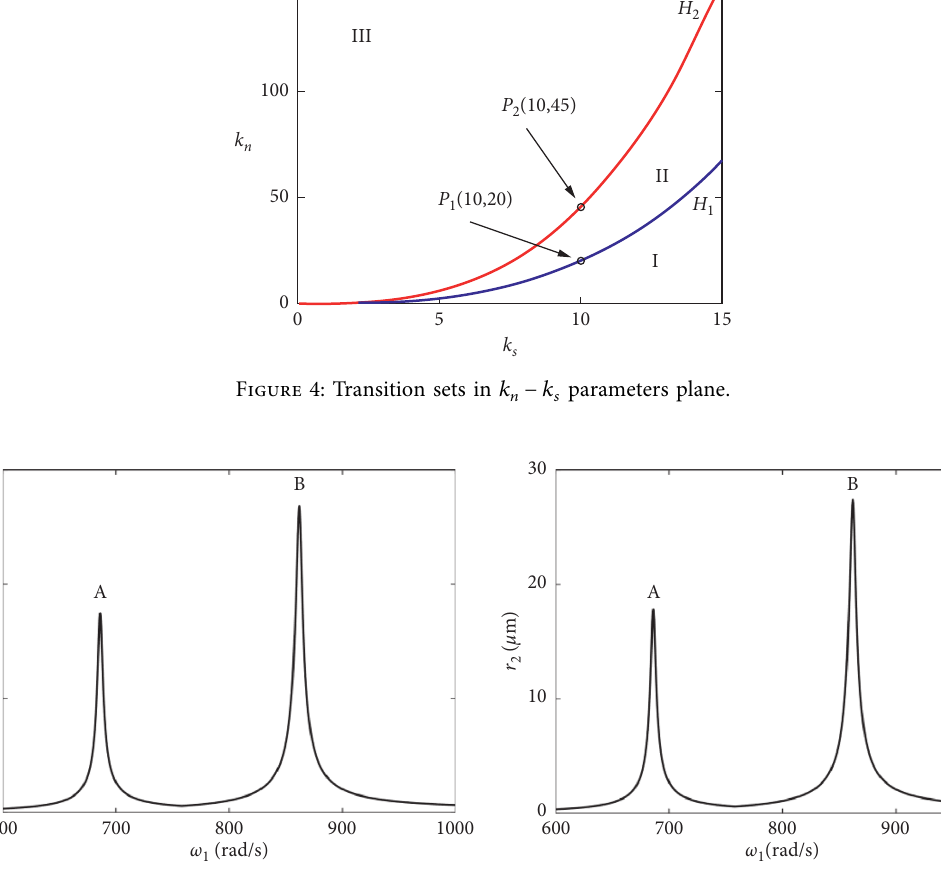
� 1 × 10 23 N/m 3 , k � 12 × 10 8 N/m). (a) For n s